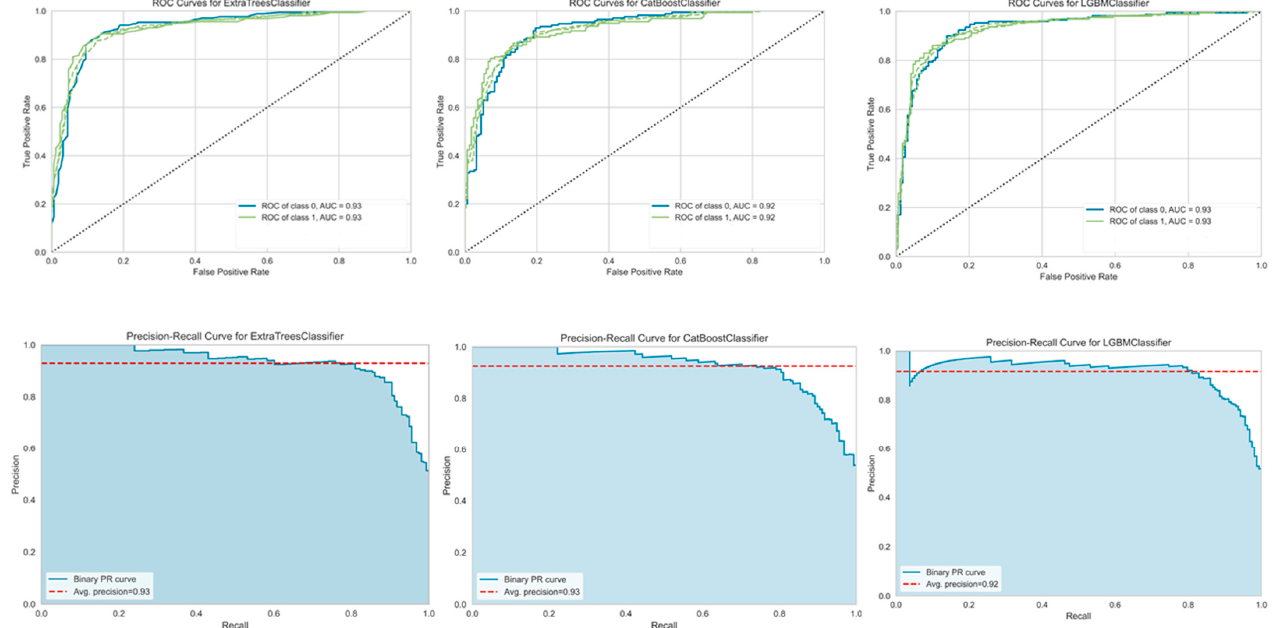
Figure 4. The area under the receiver operating characteristics (AUC) curve and the area under the precision–recall (AUCPR) curve show model performances, developed using selected features on the holdout set. Table 2. Performances and comparison with state-of-the-art machine learning models based on hy- brid features for the benchmark training and test datasets. The values shown are mean ± standard deviation for the training dataset.